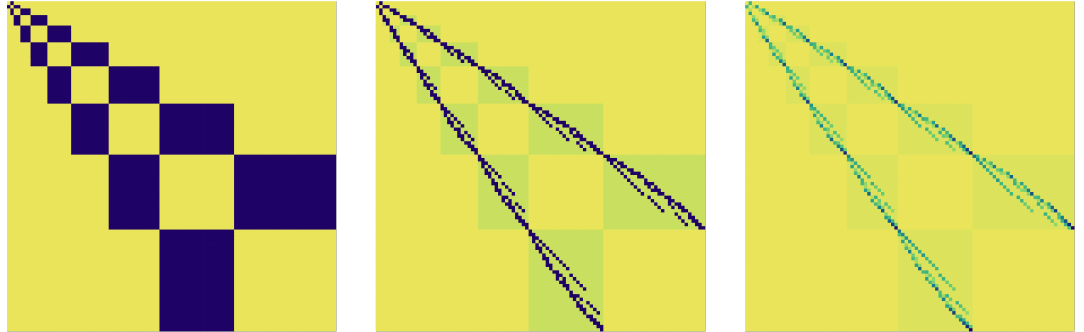
Figure 4 . [Left] The naive tri-diagonal form of the Liouvillian in the orthonormal basis of descendants. Each block shows a Lanczos matrix of dimensions p ( N ) × p ( N ± 1) . [Centre] The adjacency matrix of the Young’s lattice, the black elements indicate that two vertices are nearest neighbours and will have a non-zero Lanczos elements. [Right] Matrix plot of magnitudes of the Lanczos elements for h = 10 and c = 5 .